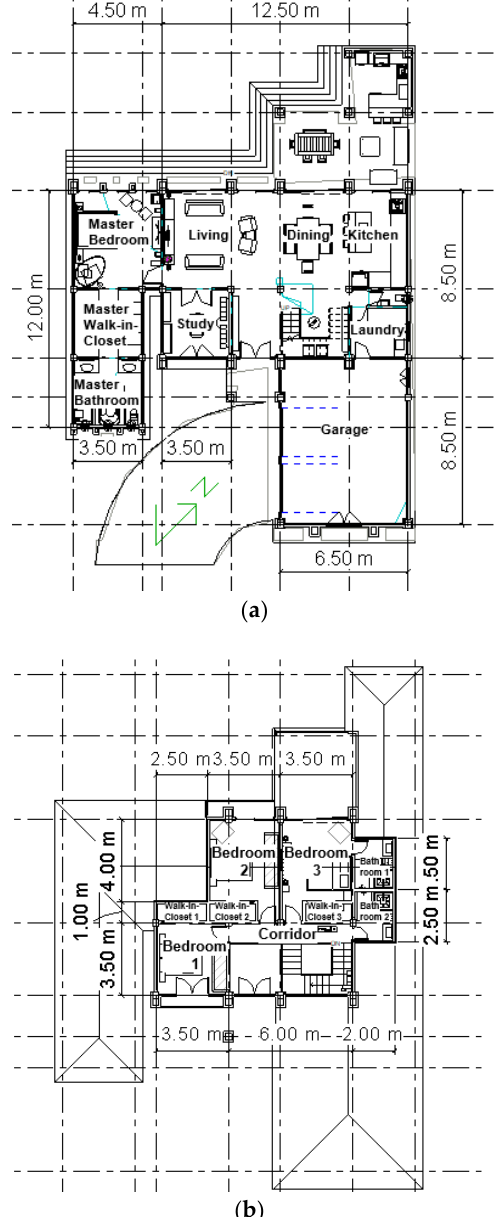
Figure 4. Floor plans. ( a ) first floor, and ( b ) second floor. Table 1. Thermal variables of selected